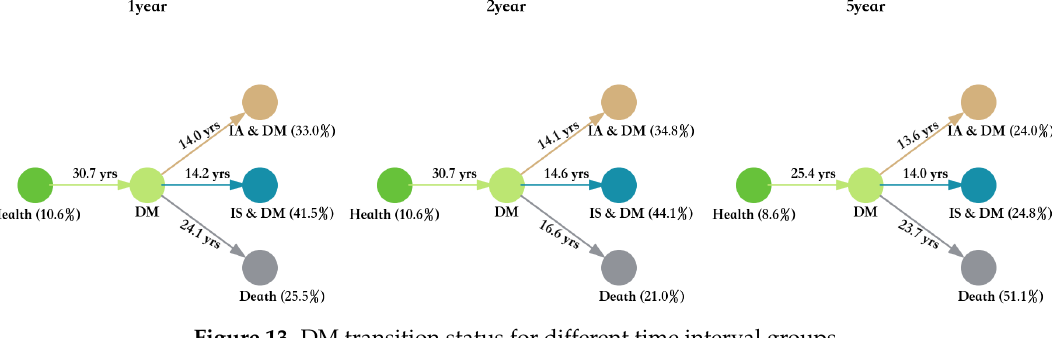
Figure 13. DM transition status for different time interval groups.